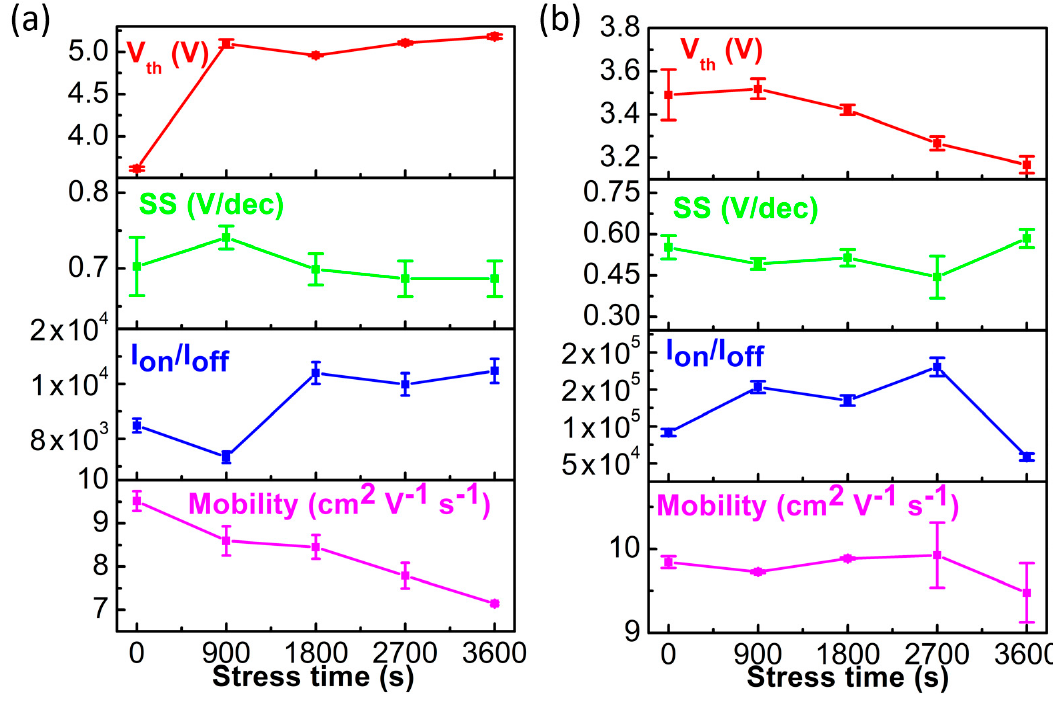
Figure 8. The trend of electrical characteristics of the TFT with ZrO 2 film fabricated by 0.6 M precursor spin-coating 3 times. ( a ) Positive bias stress. ( b ) Negative bias stress.